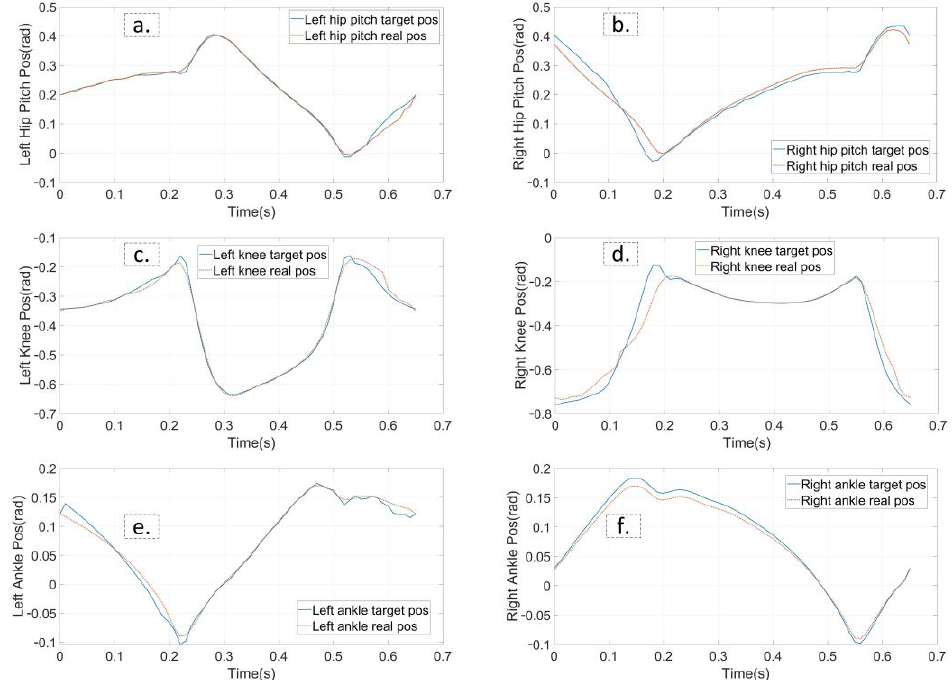
Figure 12. The planned joint position trajectories and the feedback trajectories from simulation of quincuncial piles. The tracking performance of moat walking simulation of each active joint is shown from ( a – f ). The target position trajectories is represented in blue and real trajectories in red.